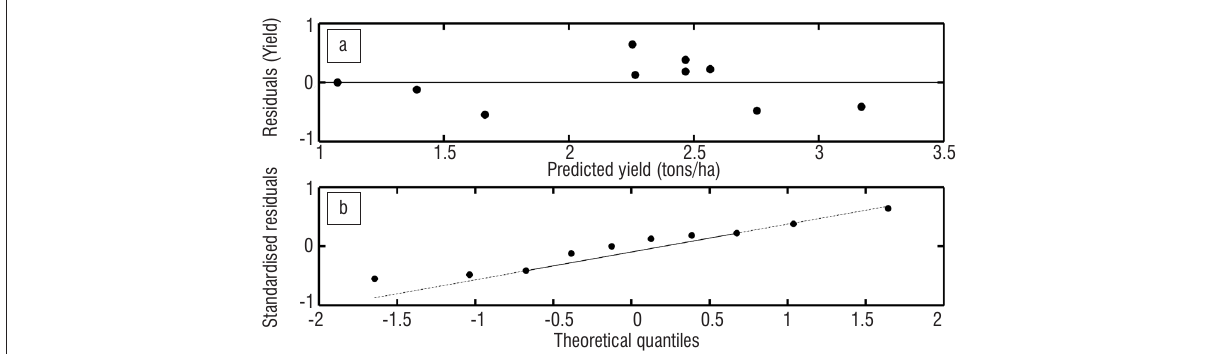
a S t Theoretical quantiles Figure 3: Model validation diagnostic plots. (a) Residual plot displaying randomly distributed residuals indicating that the linear model is the appropriate fit for the data. (b) Q-Q plot indicating that the residuals are normally distributed.